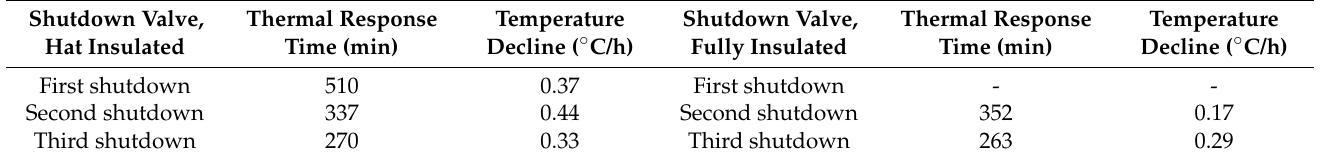
Table 2. Thermal response time and slope of temperature decline during cooling for the shutdown valve; data for hat insulation are from previous tests